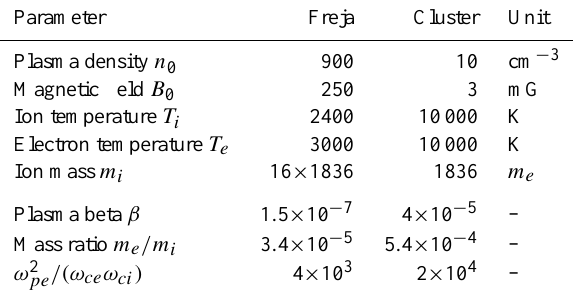
Table 1. Plasma parameters and derived dimensionless quantities relevant for LHSS observations in the topside ionosphere (Eriksson et al., 1994, Freja) and magnetosphere (Tjulin et al., 2004a, Clus- ter). Magnetosphere temperatures are assumed values. The values for Freja are used in the numerical study (Sect.